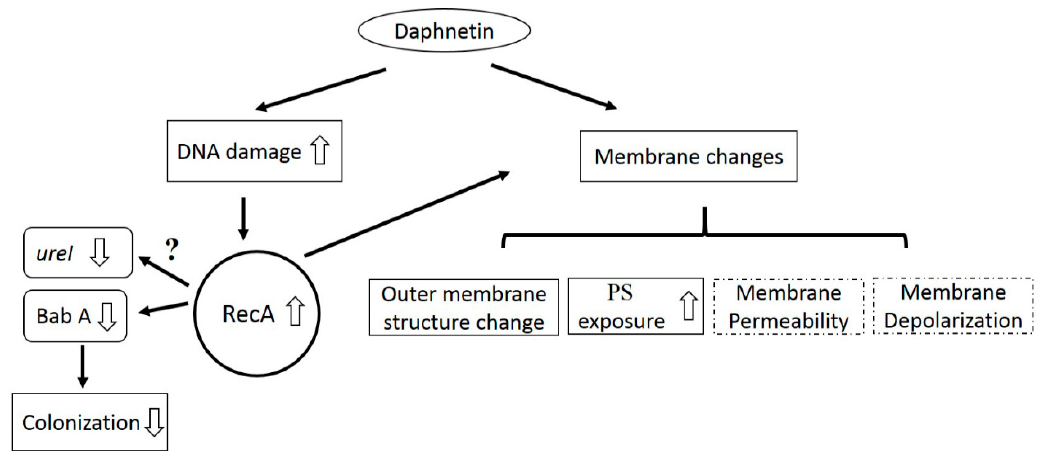
Figure 6. Hypothesized model of the mechanism(s) of daphnetin against H. pylori. Daphnetin exposure caused DNA damage and subsequently induced recA expression. In addition, recA negatively regulated babA transcription. To our best knowledge, no study indicated a direct interaction between recA and urel . Lower babA and urel transcription, and their respective protein production could reduce H. pylori adherence to GES-1 cells. Moreover, daphnetin exhibited effect on membrane changes (e.g., outer membrane structural change and increased PS exposure). In the current study, no significant impact of daphnetin on membrane permeability and depolarization was